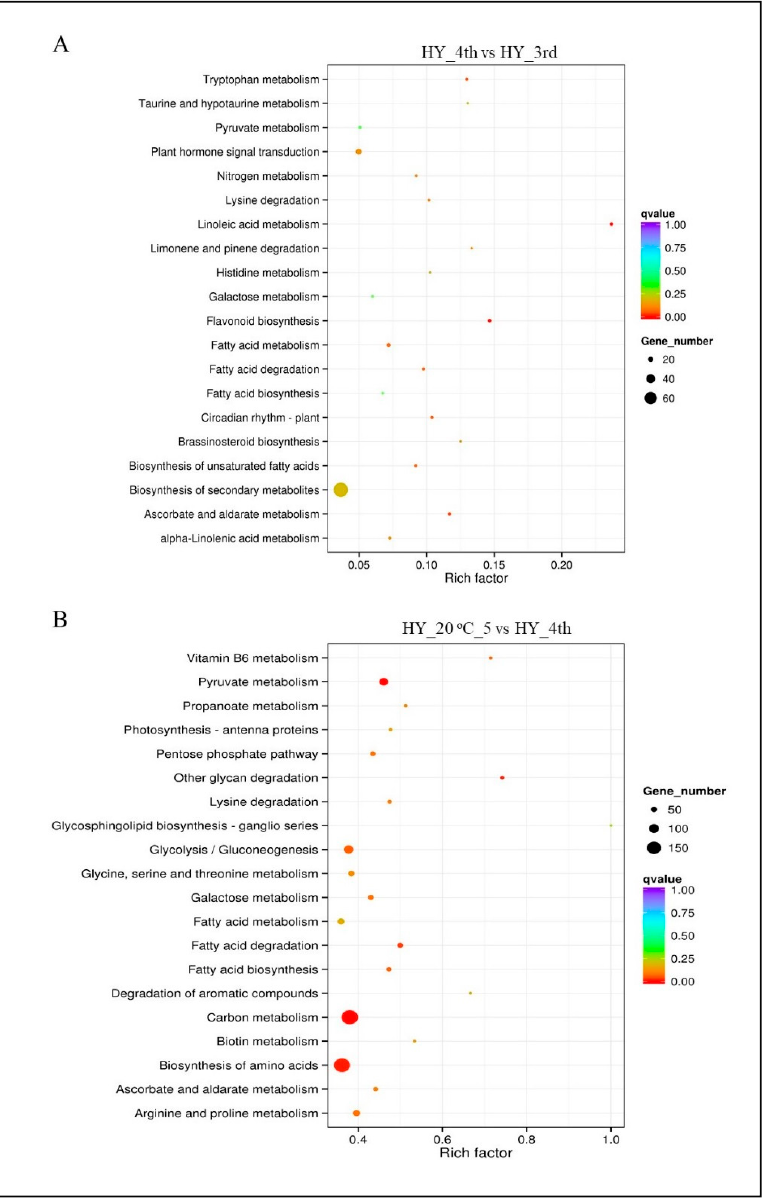
Figure 4. KEGG pathway enrichment concerning differently expressed genes in pre- ( A ) and post-ripening ( B ) apple. Top 20 enriched KEGG pathways were exhibited in each cluster. Rich factor is the ratio of DEGs counts to this pathway in the annotated genes counts. The more the q-value is close to zero, the more significant is the enrichment.